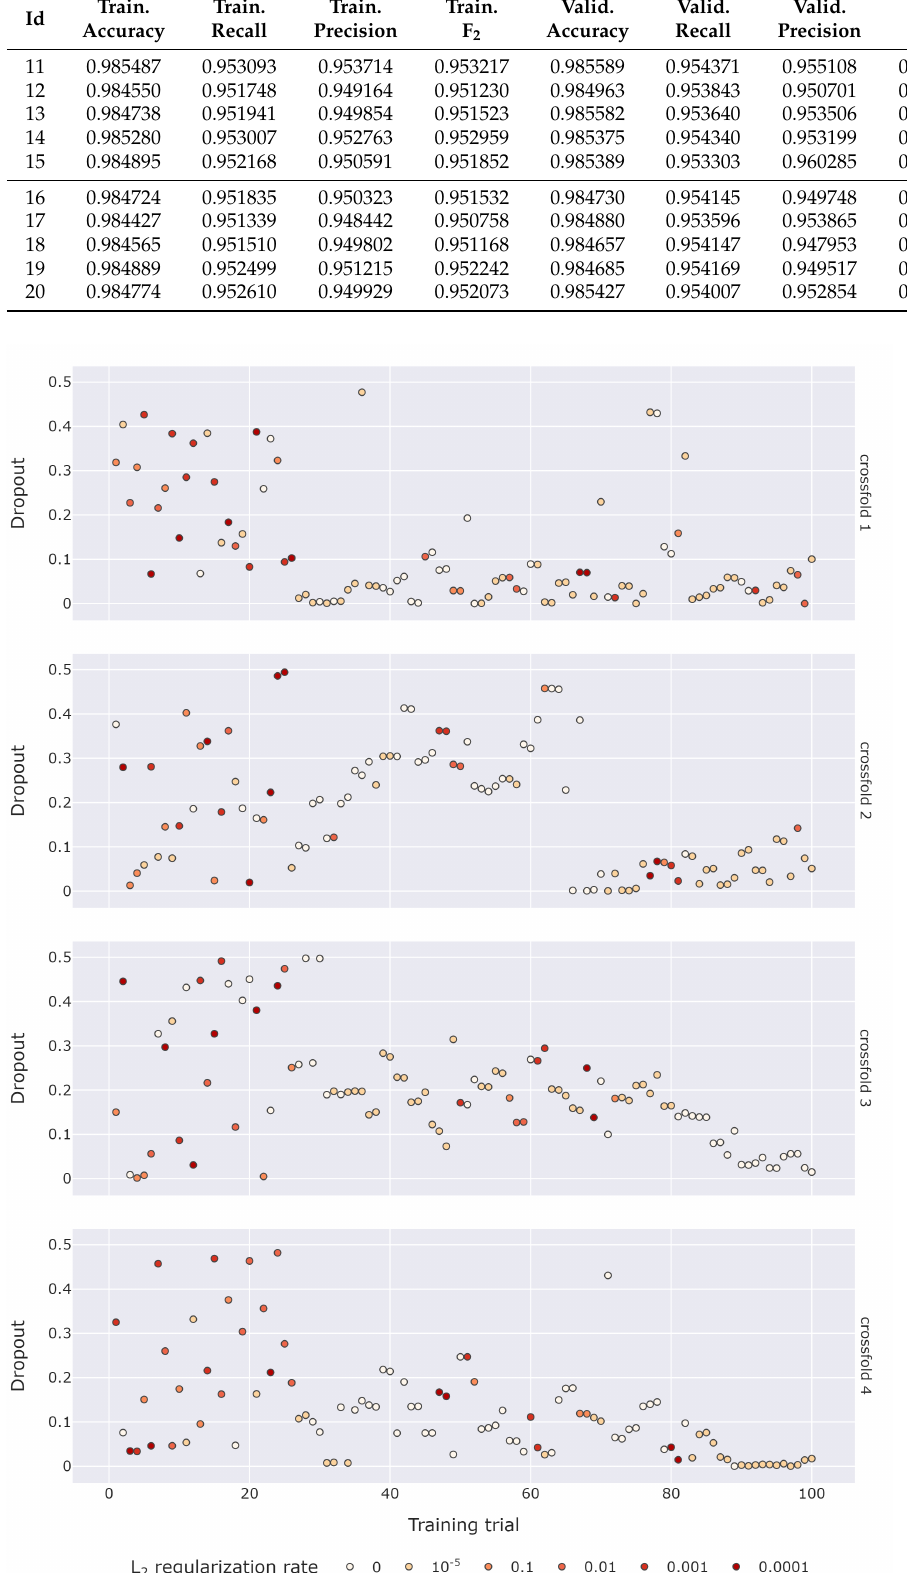
Figure 5. Changes in dropout and L 2 regularization rate during trials for each